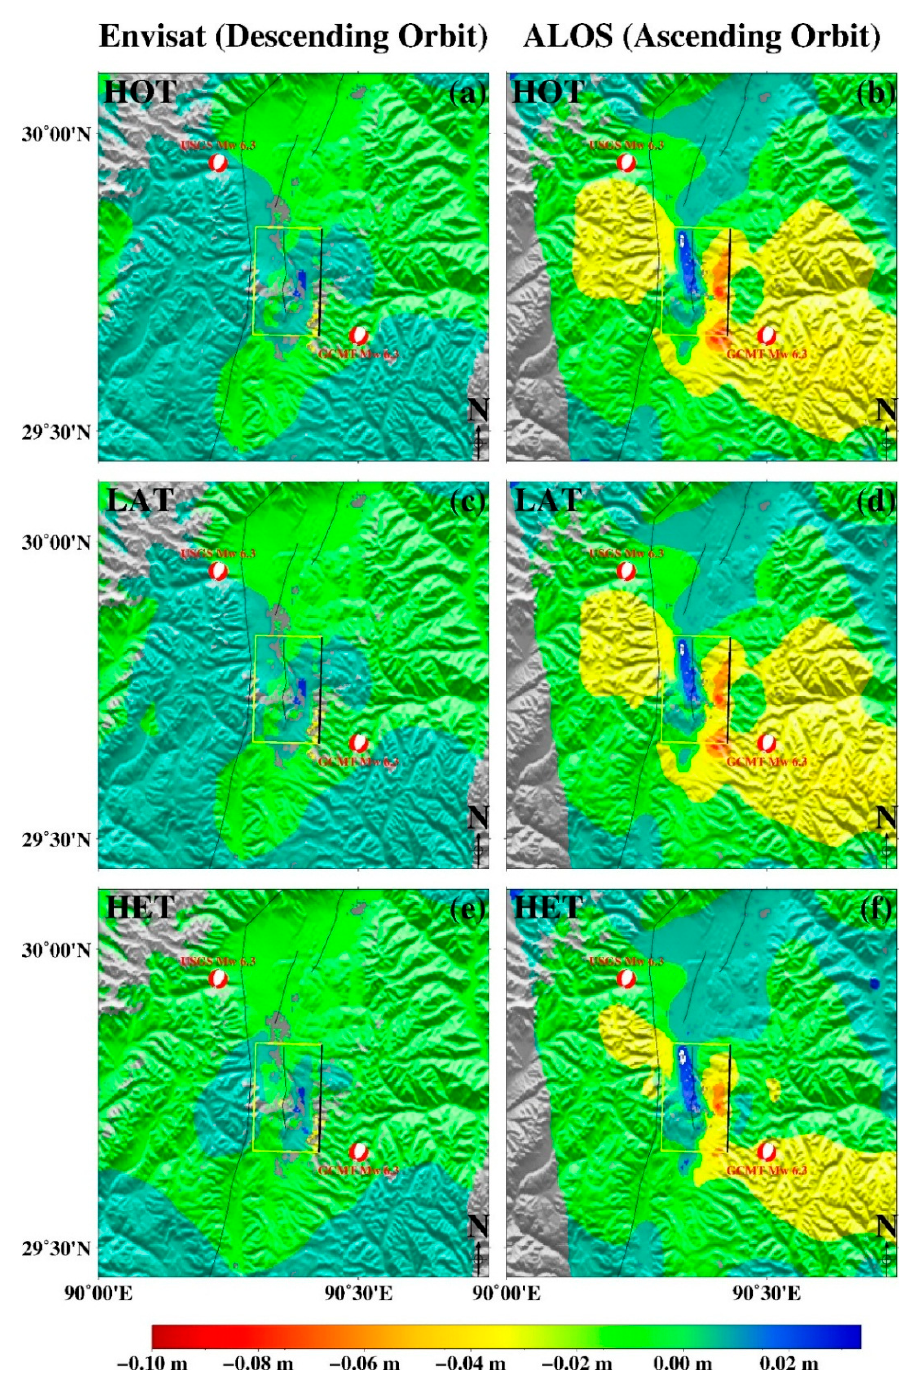
Figure 13. Fit residuals for descending and ascending datasets in LOS. ( a , c , e ) Envisat ASAR Track 176 estimated by the HOT model, LAT model, and HET model, respectively; ( b , d , f ) ALOS PALSAR Track 500 estimated by the HOT model, LAT model, and HET model, respectively. Yellow box denotes the fault surface projection on the ground with the black line as its top. Thin black lines denote the Quaternary active faults [36]. Red beach balls represent the earthquake source mechanisms (from USGS and